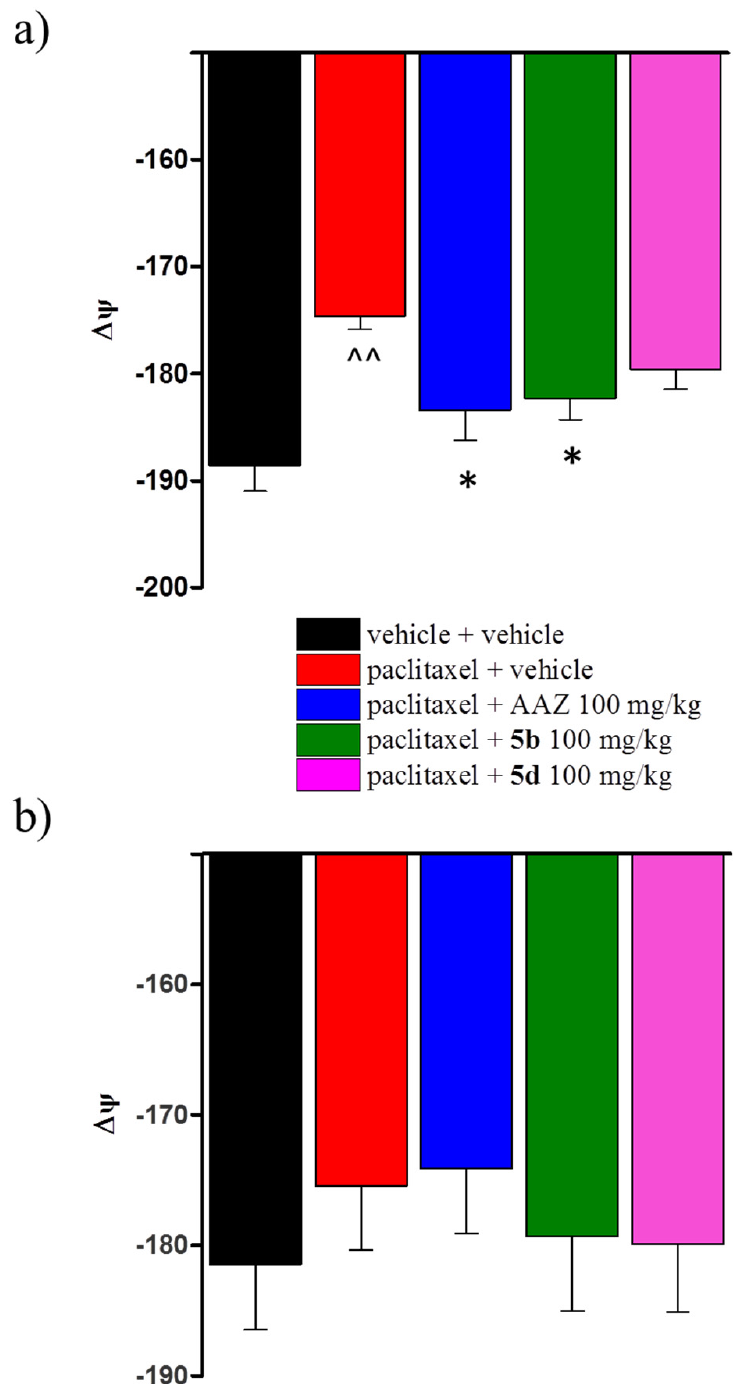
Figure 6. Histograms showing the mitochondrial membrane potential ( ∆Ψ , mV) value measured in mitochondria isolated from the brain ( a ) and spinal cord ( b ) of animals submitted to pharmacological treatments. Data are expressed as the mean ± S.E.M. of values from five brain and five spinal cord tissue samples per group. ^^ p <0.01 vs. vehicle + vehicle; * p < 0.05 vs. paclitaxel + vehicle. CS activity is considered a marker of cell metabolism, but being the first enzyme of the Krebs cycle, it is widely used as marker of mitochondrial function. According to the mitochondrial damage induced by treatment with paclitaxel, we observed a significant reduction in CS activity, in organelles isolated from the brain and spinal cords. On the